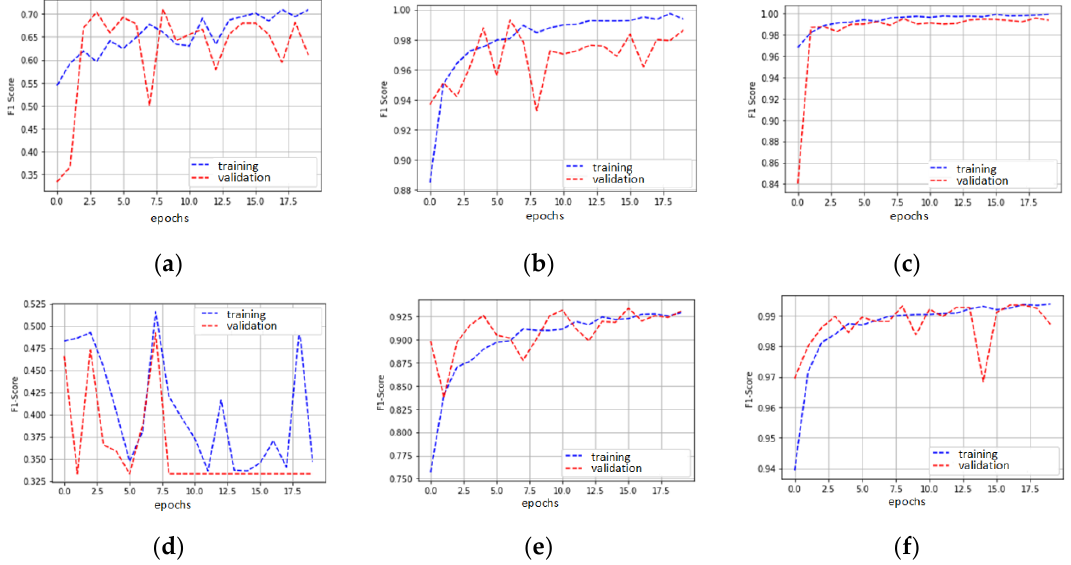
Figure 4. F1-scores using different datasets: ( a ) custom model using DA; ( b ) custom model using DB; ( c ) custom model using DC; ( d ) VGG-16 based model using DA; ( e ) VGG-16-based model using DB; ( f ) VGG-16-based model using DC.